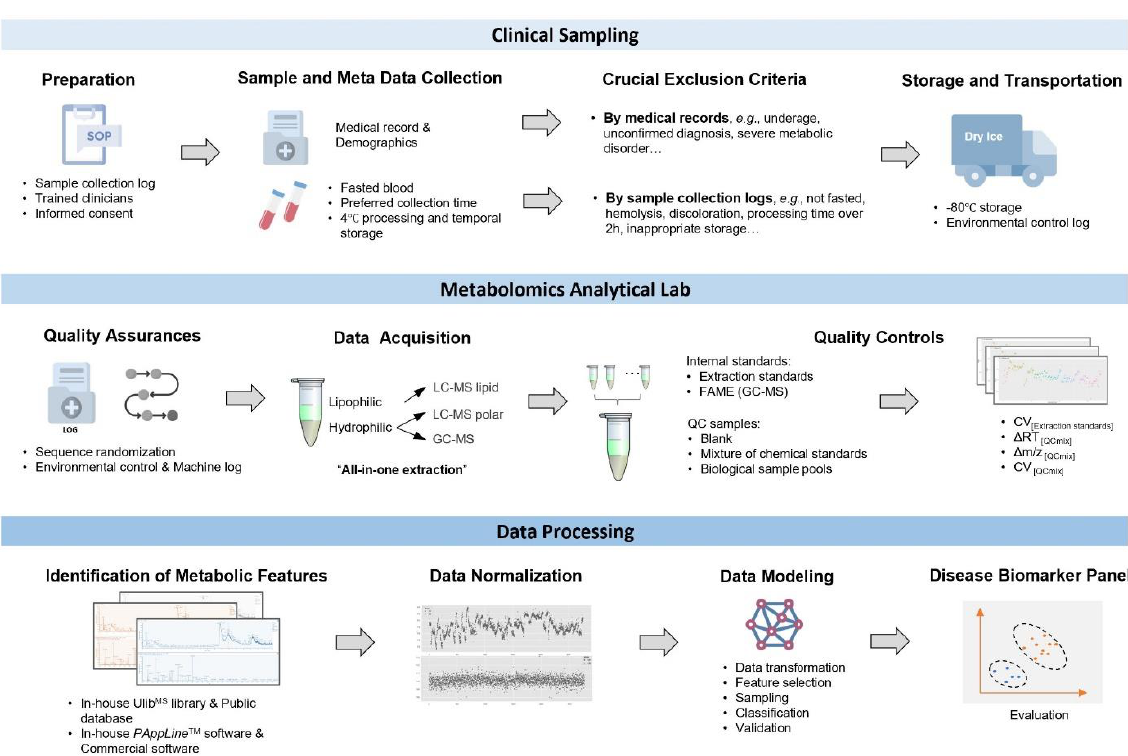
Figure 1. The workflow for a clinical-oriented metabolomics study.